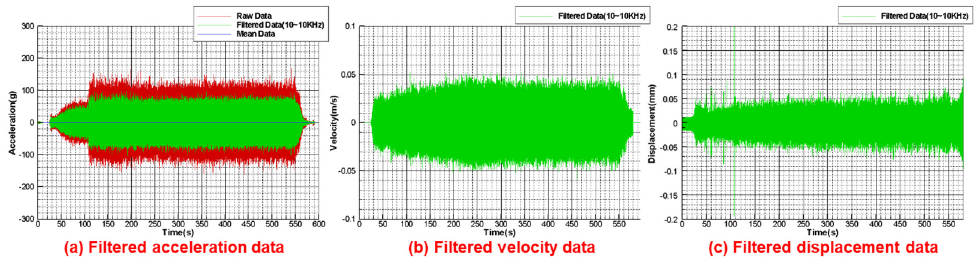
Figure 17. Acceleration, velocity, and displacement of LOx pump with middle nose.